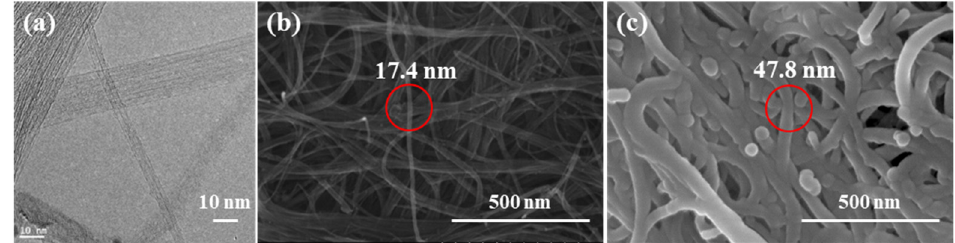
Figure 3. TEM and SEM images of ( a ) SWCNTs, ( b ) a surface of SWCNTs paper and ( c ) a surface of SWCNT/epoxy composite.